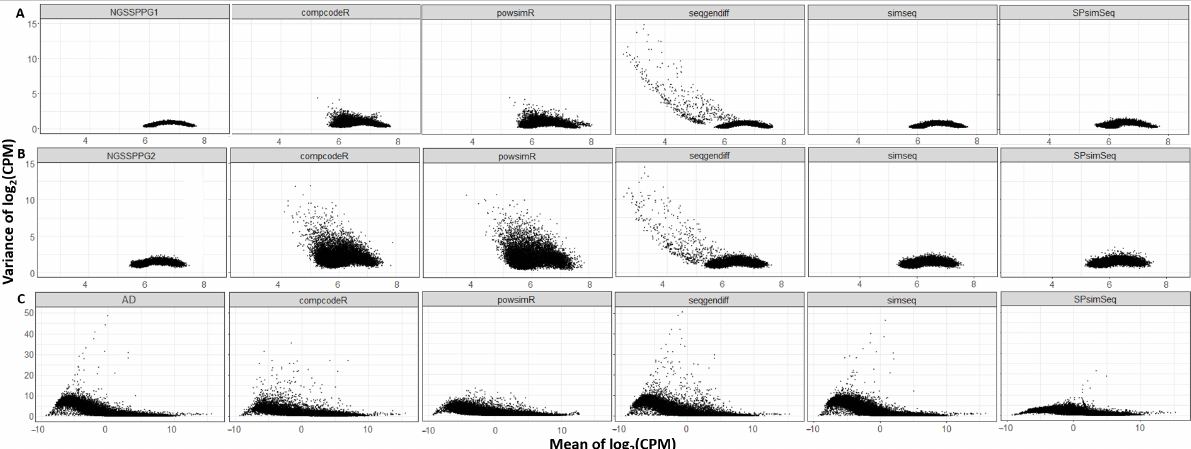
Figure 5. Mean-variance plots of the: ( A ) NGSSPPG1; ( B ) NGSSPPG2; and ( C ) AD datasets and the datasets generated with these as input.